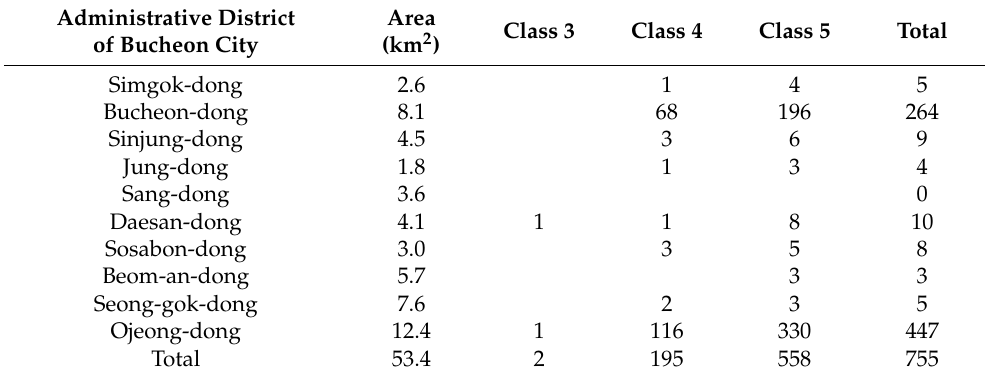
Table 1. Air-pollutant-emitting facilities in Bucheon City [8].